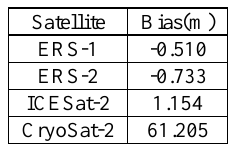
Table 3. Bias correction during the overlap period of altimetry